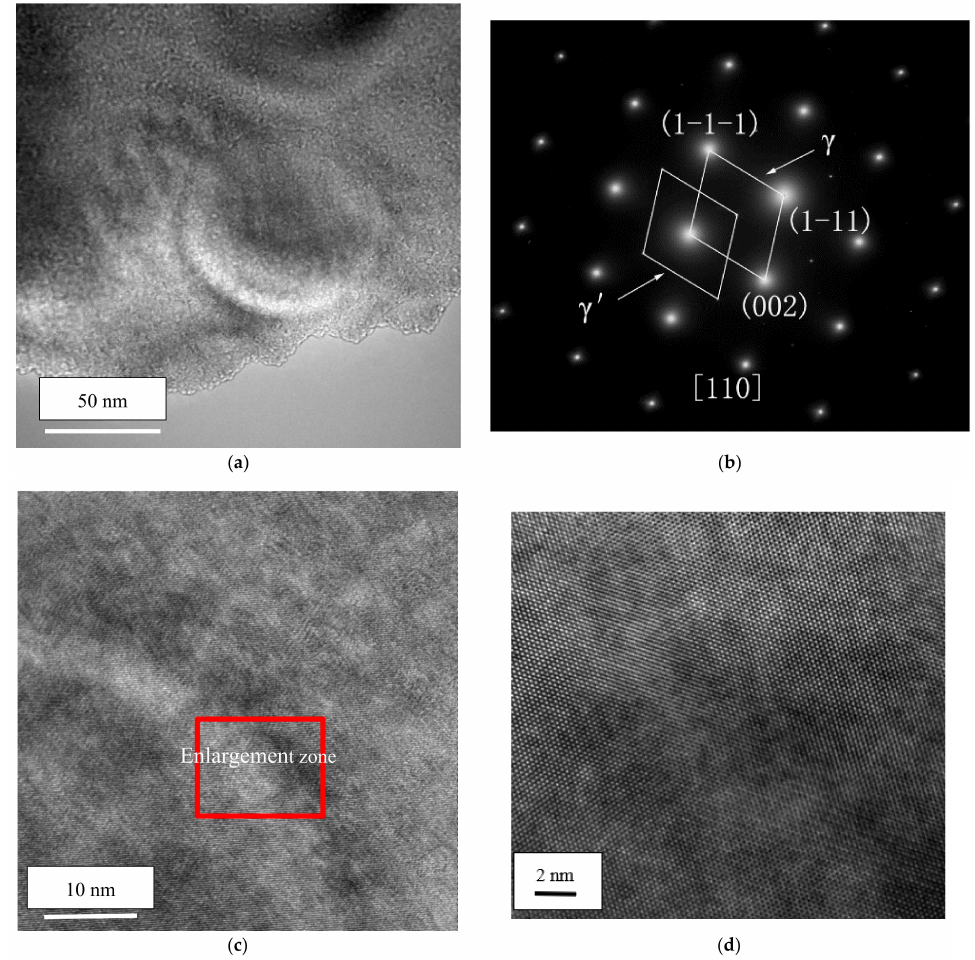
Figure 6. Interface structure between the γ and γ (cid:48) phases observed by HR-TEM. ( a ) γ (cid:48) phase; ( b ) selected area electron diffraction of γ (cid:48) ; ( c , d ) are HR-TEM